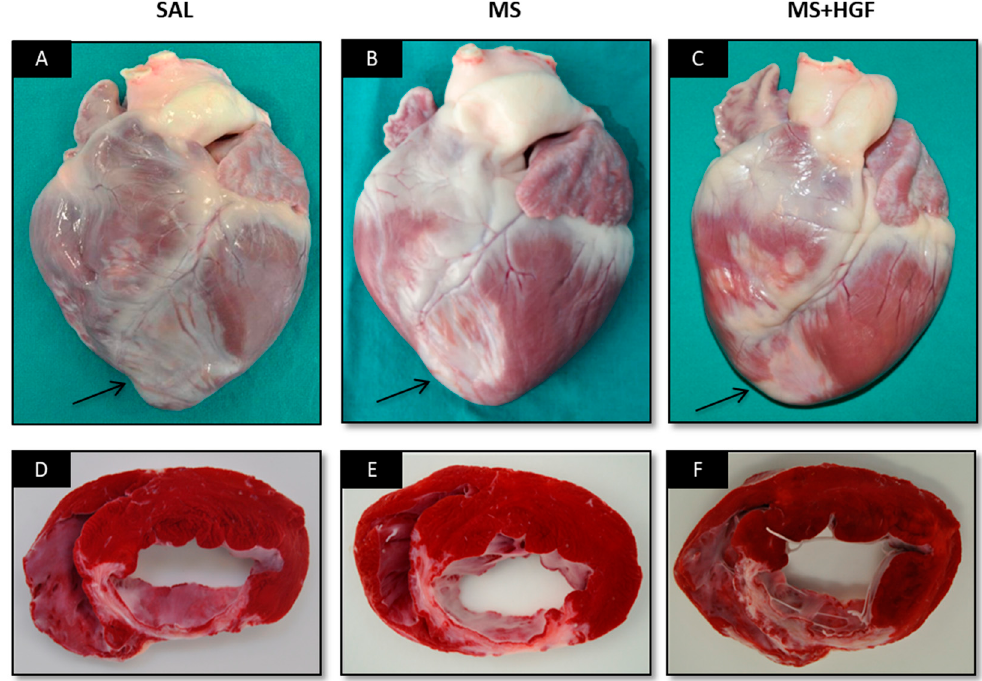
Figure 7. Necropsy study. Photographs of representative hearts from the SAL ( A , D ), MS ( B , E ) and MS+HGF ( C , F ) groups and their TTC-stained slices. The arrows point the infarct area in each group. Table 8. Histological parameters of the three groups with H&E and MTC staining. Regarding histopathologic examination, the slices from two animals in the MS group